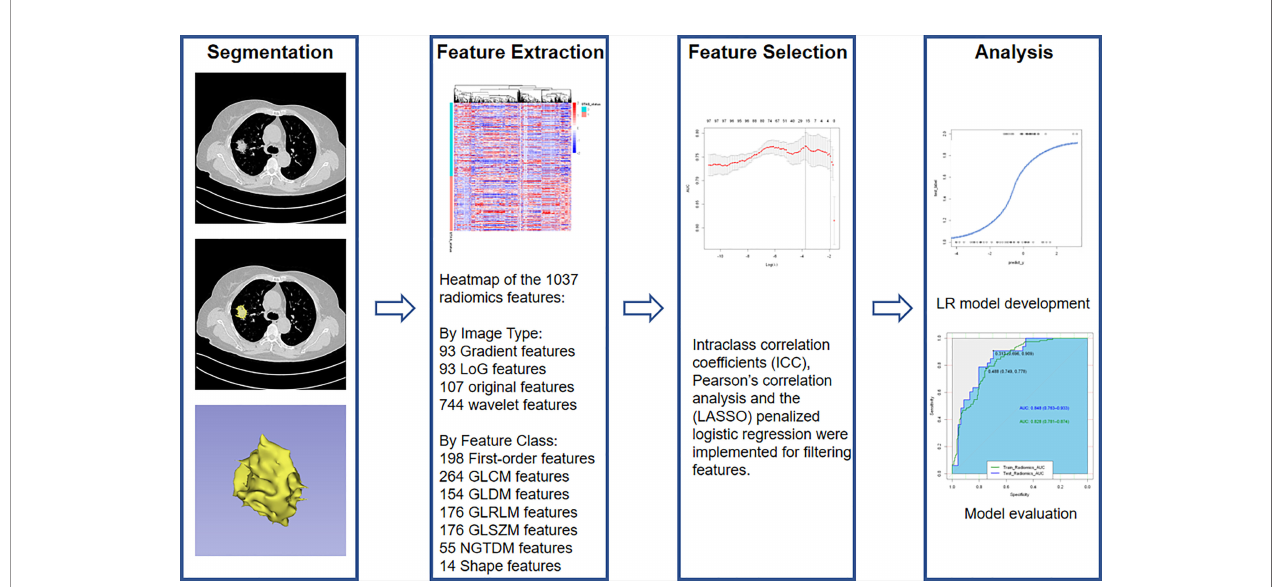
FIGURE 2 | Radiomics work fl